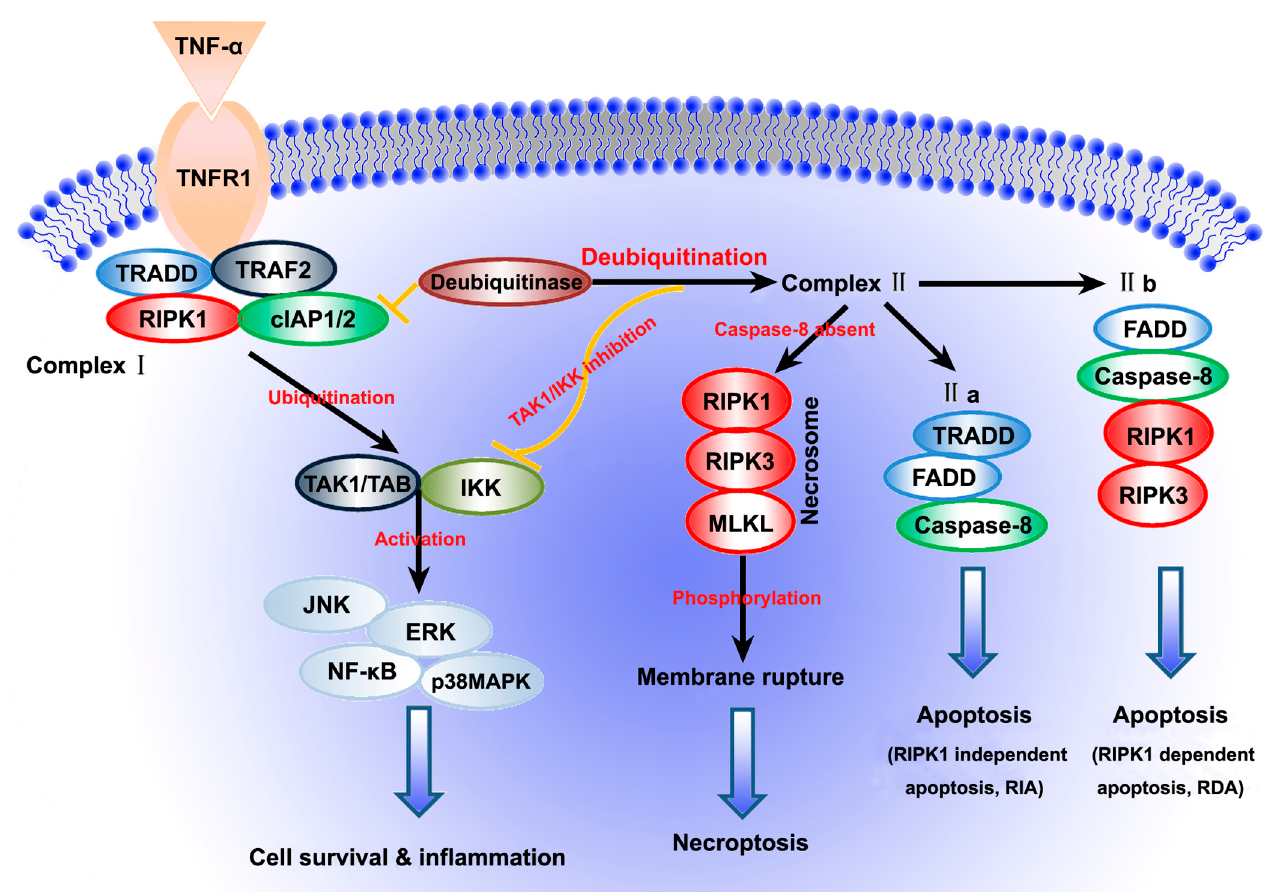
Figure 1. Tumor necrosis factor-alpha (TNF- α )/TNF receptor 1 (TNFR1)-mediated inflammatory response and cell death pathways. The binding of TNF- α to TNFR1 triggers inflammatory responses, apoptosis and necroptosis. Ubiquitination of receptor interacting protein kinase 1 (RIPK1) promotes cell survival and induces an inflammatory response by activating the NF- κ B, p38 MAPK, JNK and ERK signalling pathways. If caspase-8 is present in cells, deubiquitination of RIPK1 results in the formation of either complex IIa or complex IIb, leading to RIPK1-independent apoptosis (RIA) or RIPK1-dependent apoptosis (RDA), respectively. If caspase-8 is absent, necroptosis is initiated, in which RIPk1, receptor-interacting protein kinase 3 (RIPK3) and mixed lineage kinase domain-like (MLKL) protein play a key role.